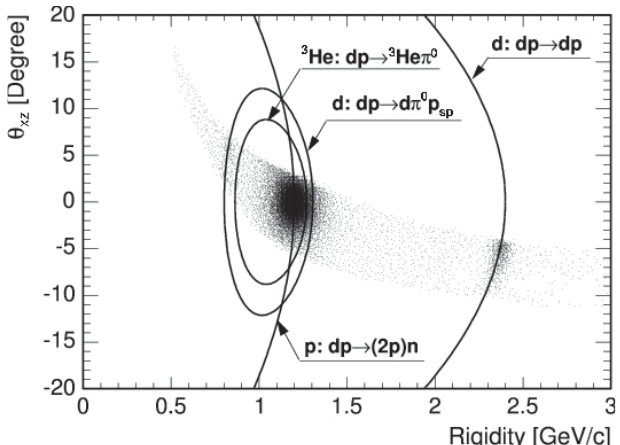
DETERMINATION OF DEUTERON BEAM . .